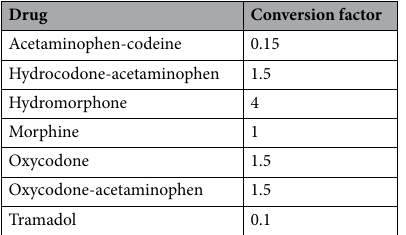
Table 1. Morphine milligram equivalents (MME) conversion factors.